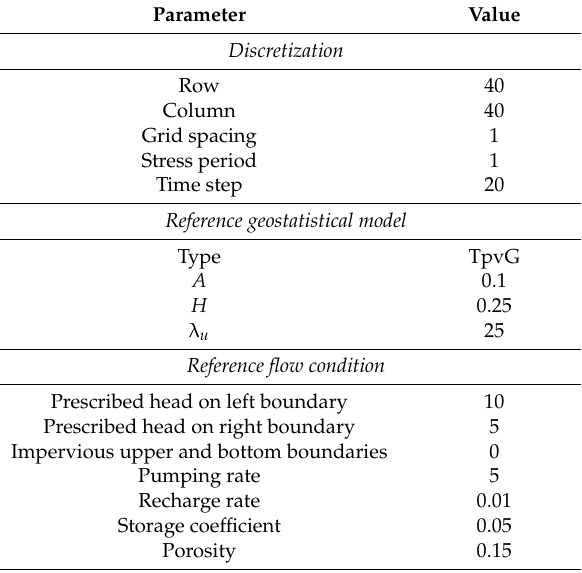
Table 1. Setting of the synthetic test to implement multi-model